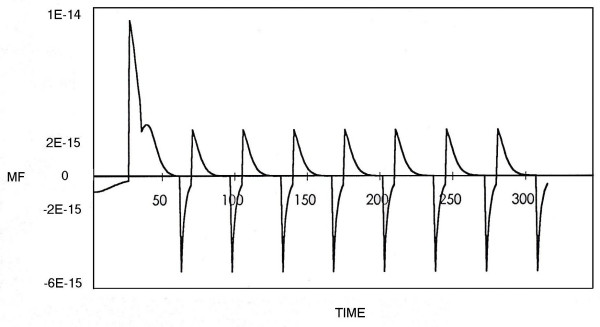
The magnetic field derived from the theoretical model with Gauss distribution. The x-axis represents the time sequence and the y-axis the magnetic field. Parameters: ma = 0.7, θa = 6,  = 14, ha = 0; mb = 0.08, θb = 4,  = 240, hb = 0.02; mc = 0.02, θc = 4,  = 400, hc = 0.0; md = 0.1, θd = 4,  = 337, hd = 0; me = 0.1, θe = 4,  = 294, he = 0.03; K± = 1.